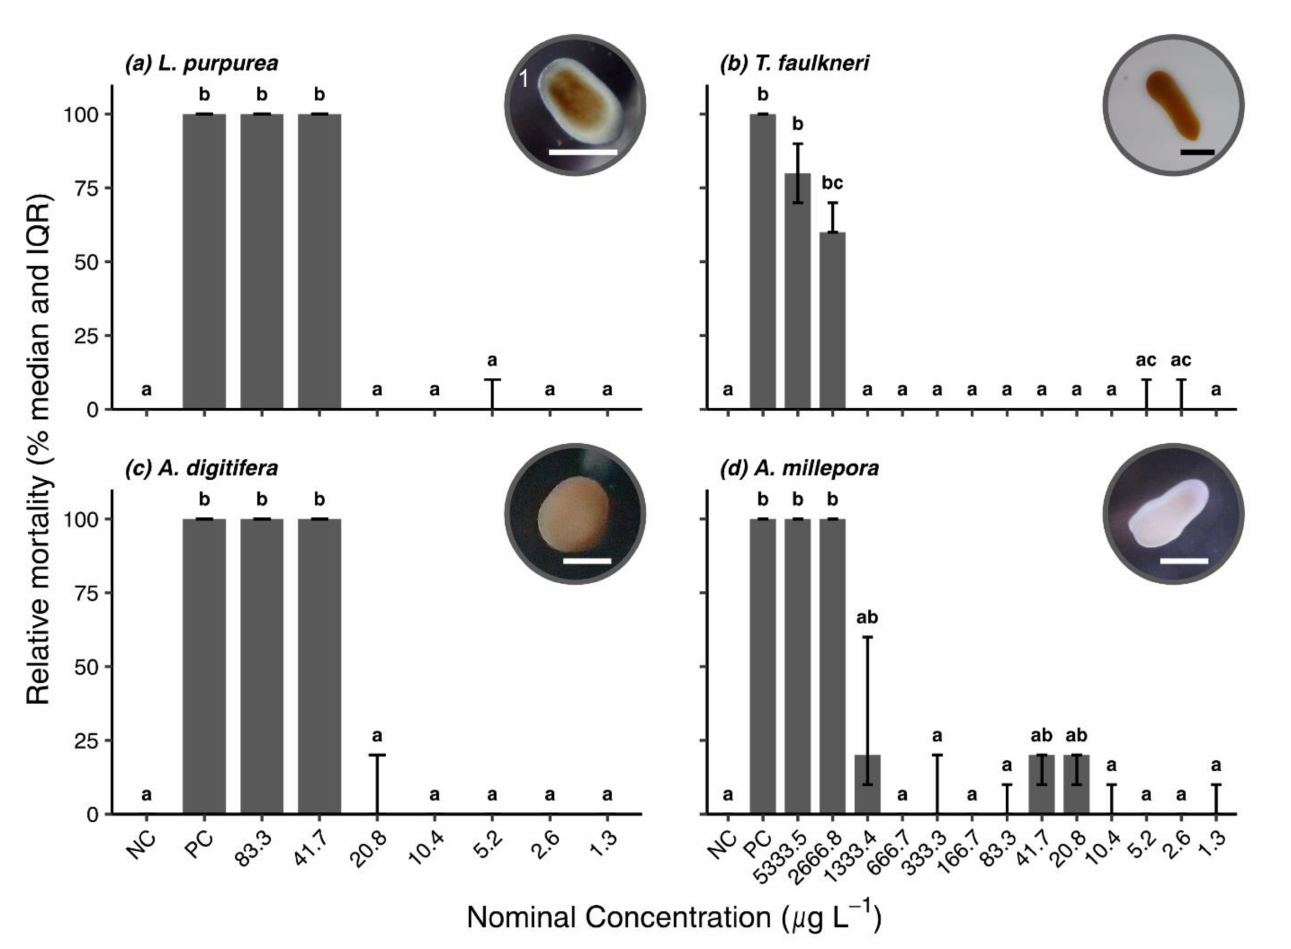
Figure 2. Results of the survival bioassays with ( a ) Leptastrea purpurea , ( b ) Tubastraea faulkneri , ( c ) Acropora digitifera and ( d ) A. millepora after 48 h exposure to BP3. Relative median mortality rate and interquartile range (IQR) are shown for each treatment (n = 3). Letters a – c indicate significance groups obtained from post hoc Dunn’s test, with same letters indicating no significant differences. Pictures showing healthy planula larvae. Scale bar = 500 µ m; NC = negative control; PC = positive control; 1 Photo courtesy of L.